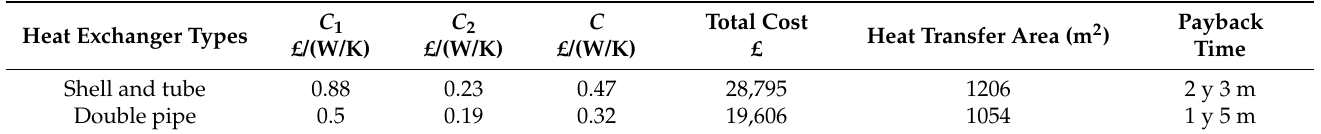
Table 7. Potential heat exchanger types with costs based on the C-value